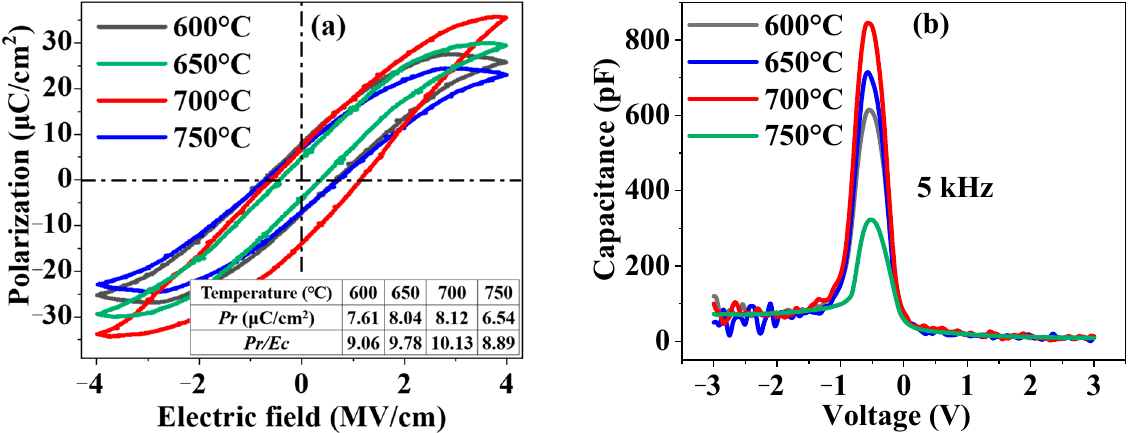
Figure 4. ( a ) P-E curves measured at 50 Hz and ( b ) C-V curves measured at 5 kHz of (Au/Cr)/Hf 0.475 Zr 0.475 Al 0.05 O y /p ++ -Si capacitors with different annealing temperatures (Al ratio: 5%).